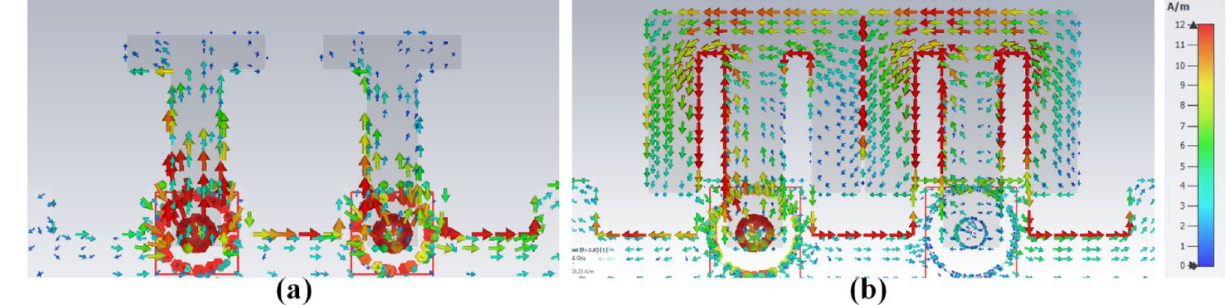
Figure 9. The density of surface current ( a ) AntI, ( b ) AntII at 3.8 GHz.